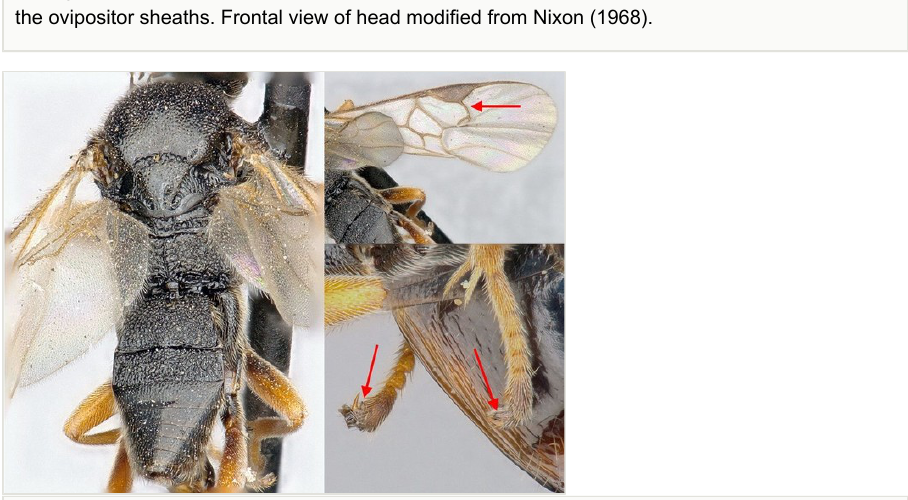
Figure 3. Microgaster deductor specimen from Abisko, Sweden. Habitus, dorsal view (left), details of fore wing (top right) and tarsal claws (bottom right). Red arrows show tarsal claw lobes, and vein r of fore